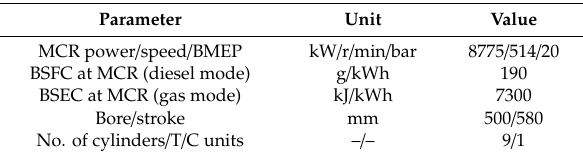
Table 1. Engine main